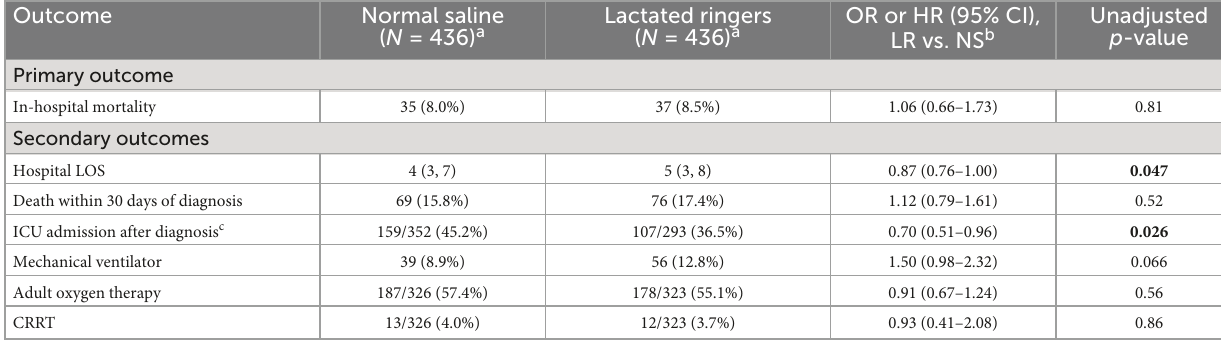
TABLE 2 Association of fluid type with outcomes in the matched LR and NS cohorts.